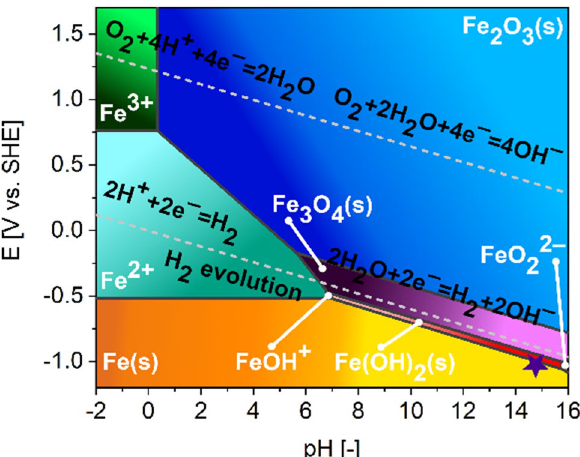
Figure 4. Pourbaix diagram for Fe. Bold lines indicate boundaries between various Fe forms. The area between dashed (water redox) lines highlights conditions under which water is stable. Above and below these lines, water is unstable with respect to O 2 and H 2 , respectively. HER operational parameters utilized in this work, for which the increase in activity in time was observed, were indicated with a star.